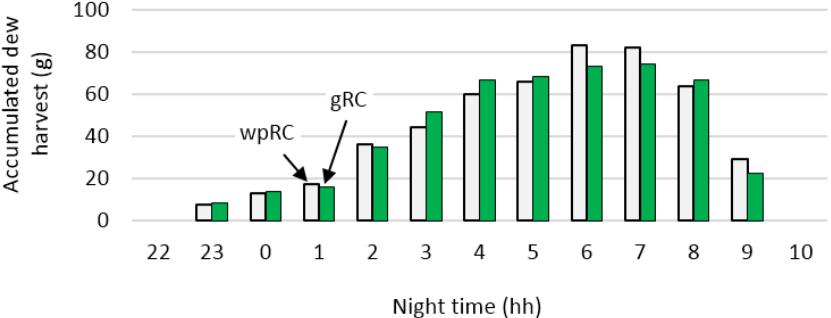
Figure 5. Hourly dew harvests during eight clear sky nights.